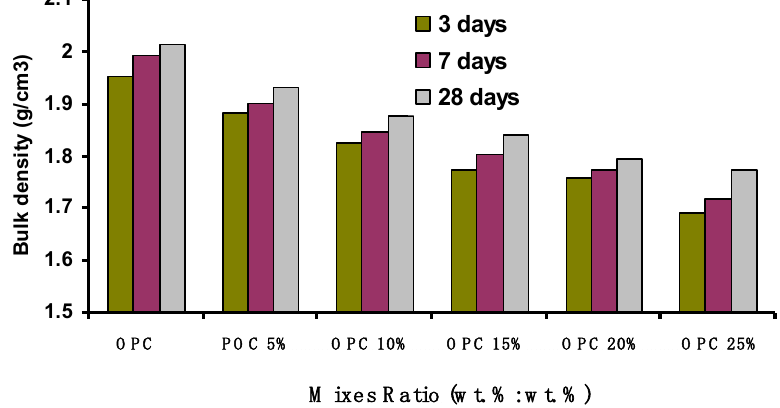
Figure 3. Bulk density of OPC and their mixes ratio with CMW.